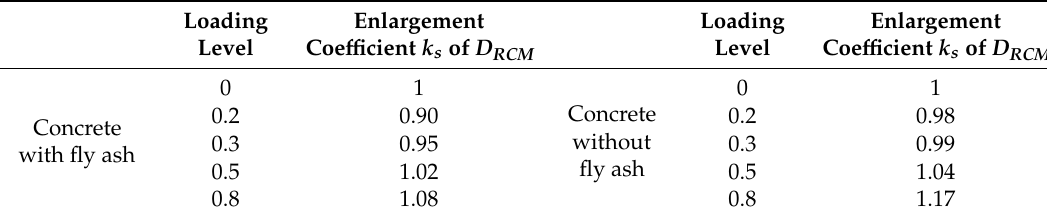
Figure 8. Variation of stress applied on reinforced bars with time. Table 3. Relationship between axial load and the enlargement coefficient k s of 𝐷 𝑅𝐶𝑀 .